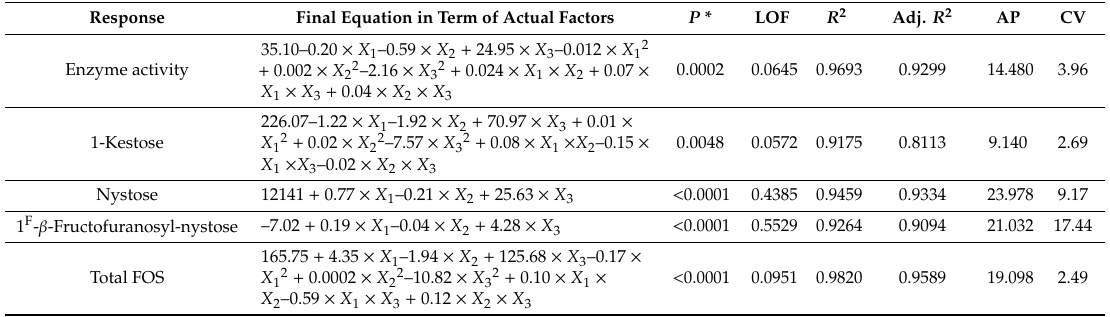
Table 3. Analysis of variance (ANOVA) of the model and coe ffi cient estimates for response parameters.